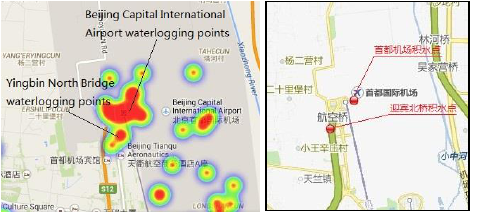
a) Heat Map about Torrential Rain b) Flooded Points by Sougou Map Figure 3. Comparison between Heat Hap of microblogging about Torrential Rain and Chart provided by the Official When we explore the distribution pattern of microblogging under different topics, Each of these microblogging was regarded as a point feature. Using the Figure 2. the trend of Sina-Weibo under different topics over method of Kernel Density Estimation, spatial distribution of time the microblogging under the topic could be obtained. We extracted microblogging with GPS information under the topic related to “traffic”. Using ArcGIS Spatial Analyst tools, spatial distribution of these microblogging is show as figure 4. In the figure 4, distribution density of the microblogging in Beijing West Railway Station, Beijing Capital International Airport and Beijing Railway Station are significantly higher than other regions. In fact, Beijing West Railway Station and Beijing Capital International Airport is transportation hubs between Beijing and other provinces. Affected by rainstorm, nearly 20 trains were delayed in Beijing West Railway Station, and a lot of flights were delayed in Beijing Capital International Airport, nearly 80,000 passengers stranded at the airport